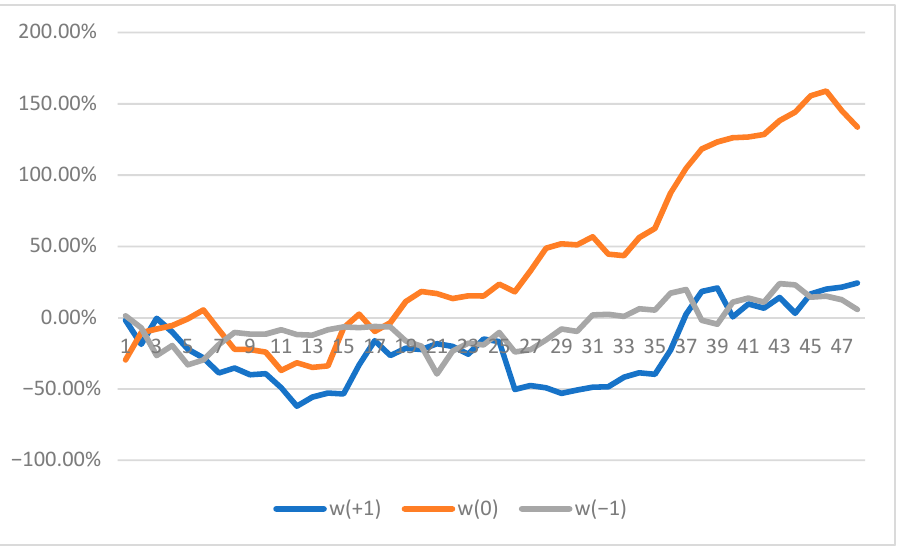
Figure 4. Trade by trade profit/loss: weekly data.